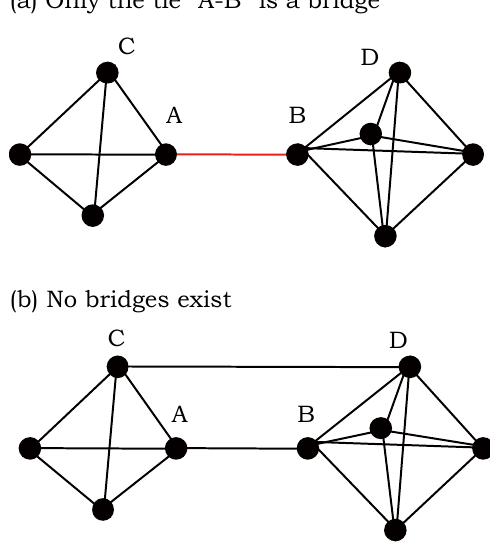
Figure 1. The concept of